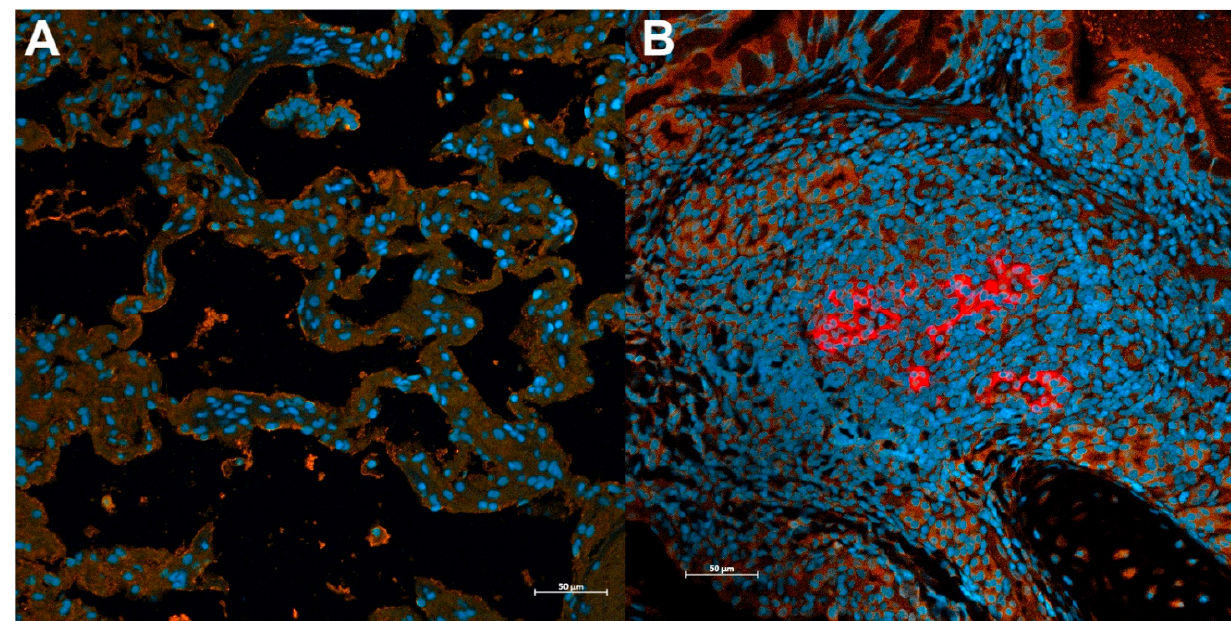
Figure 4. Immunofluorescence Assay (IFA) of SARS-CoV-2 lung infection in domestic cats. ( A ) Normal lung showing DAPI-stained nuclei (blue) and normal ACE2-expression (orange) on the surface of lung epithelial cells. ( B ) Anti-SARS-CoV-2 nucleocapsid protein (red) is present within peribronchial glandular epithelial cells expressing the ACE2 receptor (orange) in CoV-2 infected animals at 4 dpi. Blue = DAPI/nuclei; Red = SARS-CoV-2 antigen; Orange = ACE2 receptor. Magnification 20×, scale bar = 50 µm.